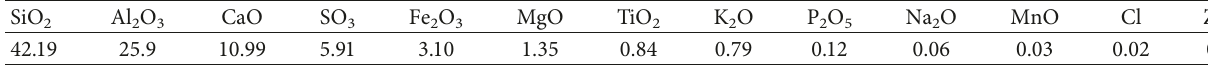
Table 1: The chemical composition of CFBC desulfurization slag (wt.%).